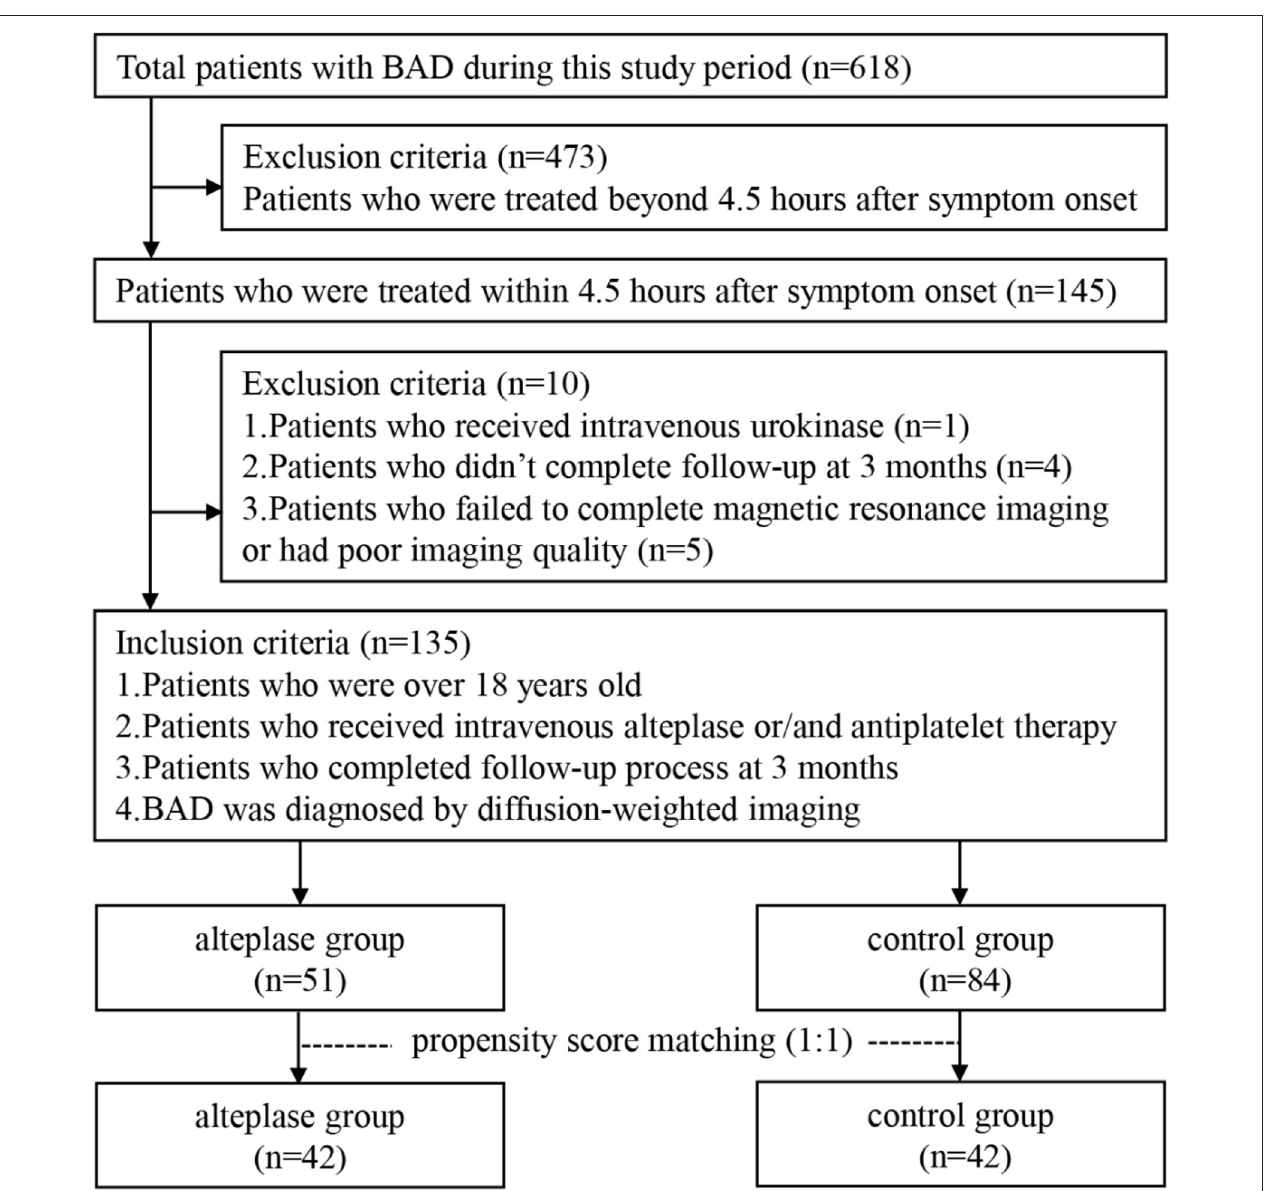
FIGURE 1 | Flowchart of selection of eligible study subjects. BAD, branch atheromatous